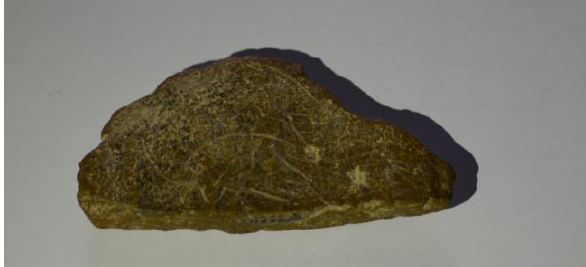
Figure 1: Uomo barbuto di Vado all’arancio